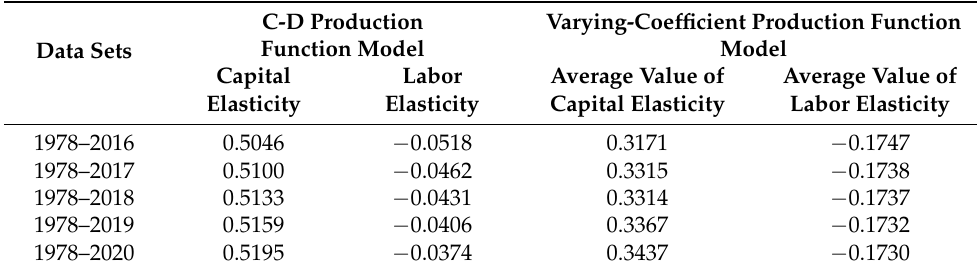
Table 1. Comparison of estimation results of two